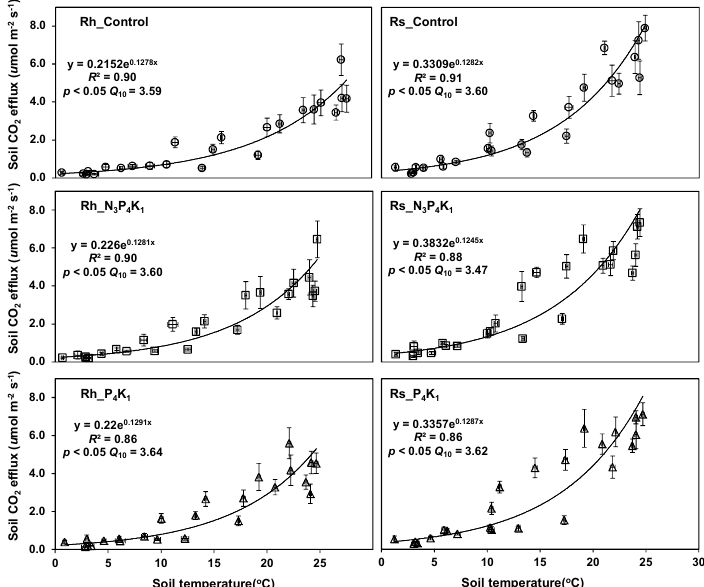
Figure 4. Exponential regressions showing the relationship between soil temperatures and Rh or Rs rates for fertilizer (N 3 P 4 K 1 : squares; P 4 K 1 : triangles) and control (circles) treatments in red pine stands. Vertical bars represent standard error ( n = 12).